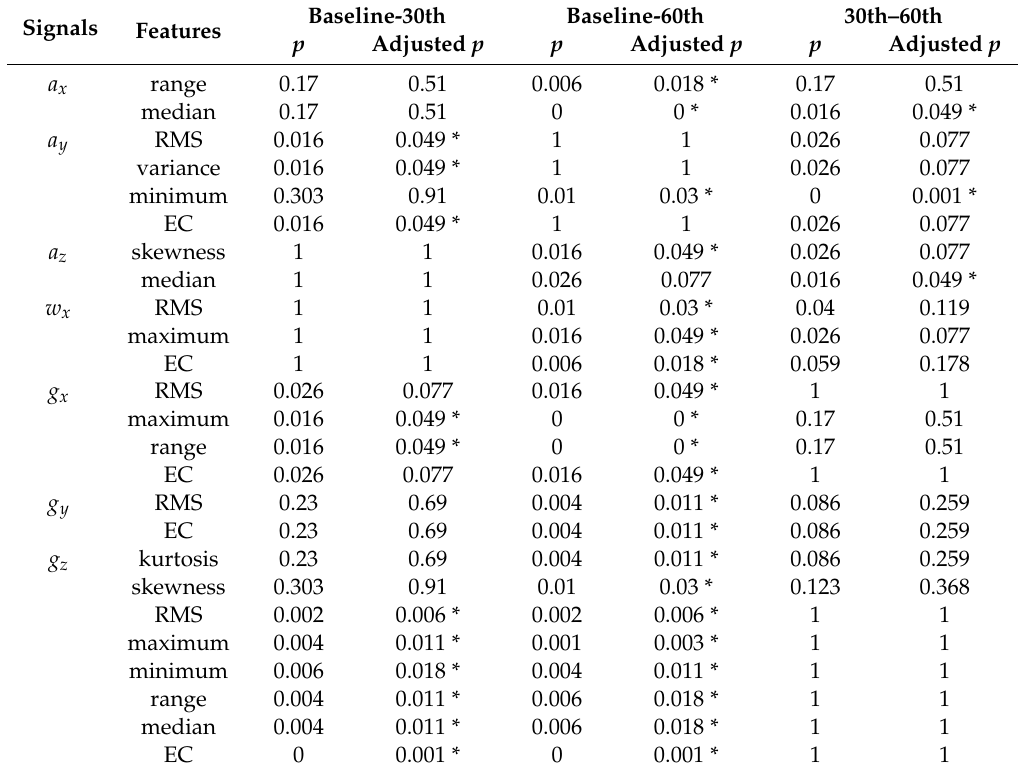
Table 3. Post hoc analysis on outcome variables with significance in the Friedman